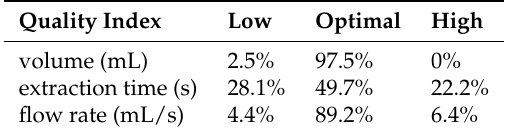
Table 3. Domain-based quality thresholds. Distribution of samples in the